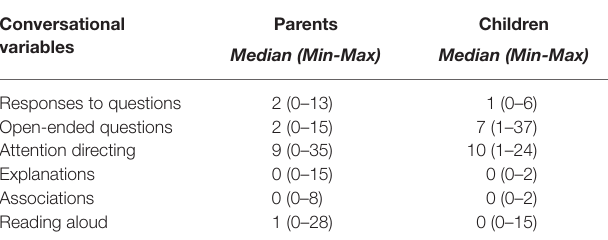
TABLE 3 | Crosstabulation of adults who asked and answered two or less or more than two open-ended questions by their learning motivation. Conversational